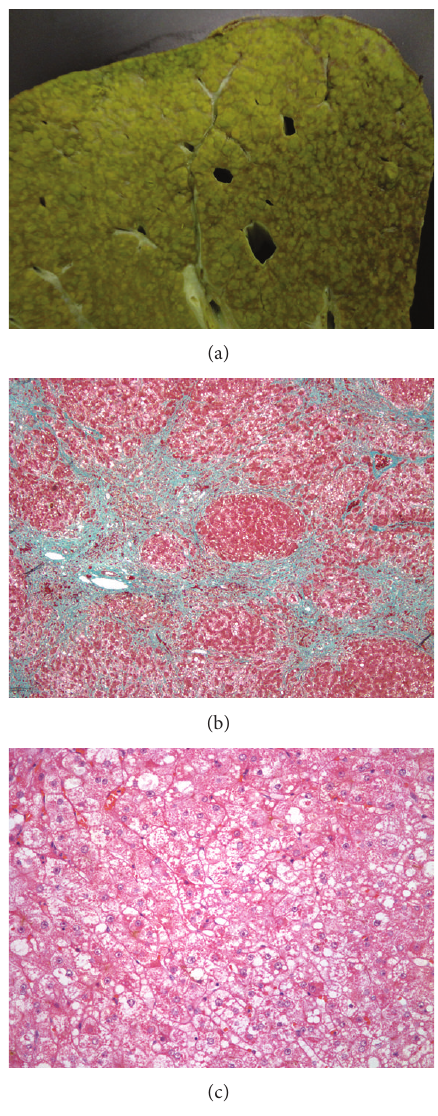
Figure 2: (a) Gross image of explanted liver with a nodular, tan- yellow surface. (b) Histologic section of liver tissue depicting exten- sive bridging fibrosis. (c) Histologic section depicting ballooning degeneration and numerous Mallory hyalines indicative of chronic